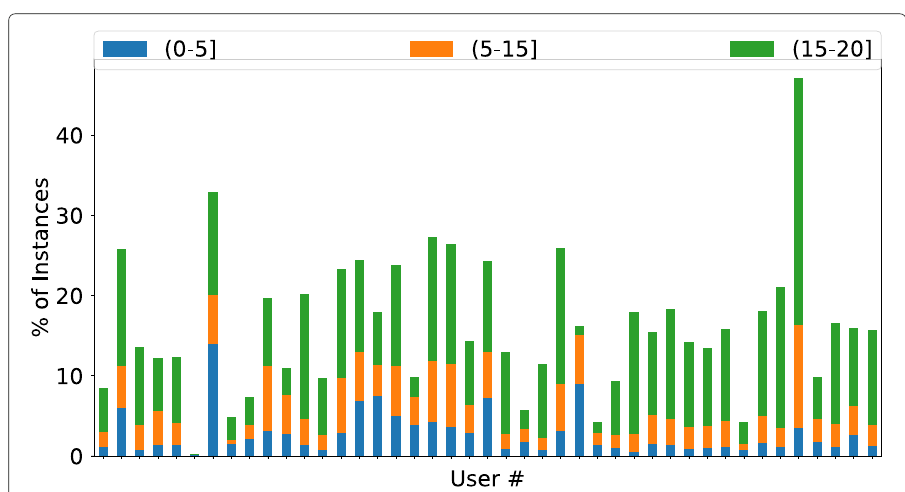
Fig. 7 Variation in Occupants’ Schedule. We sample occupancy every 30 seconds; in every 10-min interval, there exist 20 measurements of occupancy information. Here, the color indicates the number of 30 seconds instances in a 10-min interval when the room was occupied. Notice that room would be marked occupied for all the three scenarios, however, the percentage of instances when the room was occupied for less than